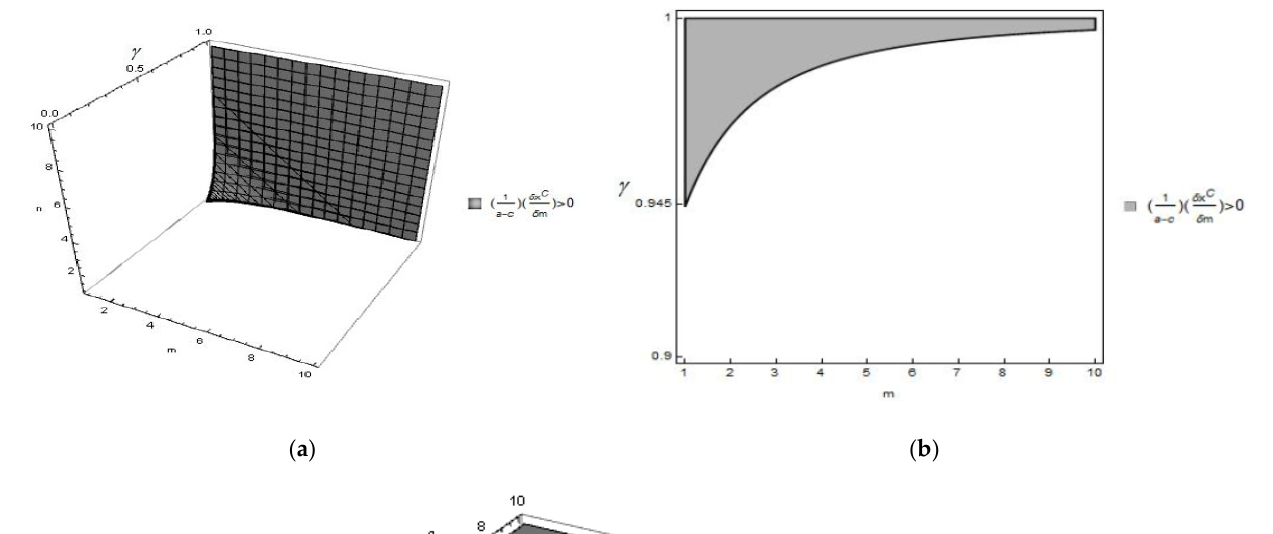
(cid:3105)(cid:3051) (cid:3252) for 𝑛 ∈ [1,10] , 𝑚 ∈ [1,10] and 𝛾 ∈ [0,1] ; ( b ) (cid:2869) (cid:3105)(cid:3040) ((cid:3028)(cid:2879)(cid:3030)) (cid:3105)((cid:3041)(cid:3051) (cid:3252) ) ((cid:3028)(cid:2879)(cid:3030))